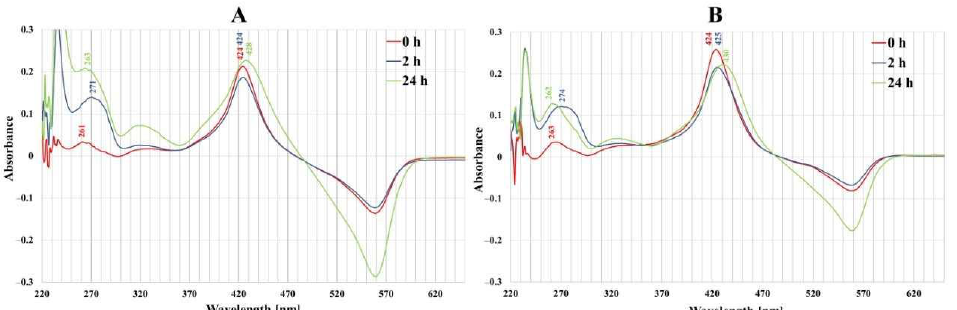
Figure 3. The UV-Vis absorption spectra of the free-base porphyrin (FB) in a post-culture media (RPMI 1640 without phenol red, 2% FCS) after 0 h, 2 h and 24 h of incubation of porphyrin with ( A ) normal colon epithelial cells (CCD 841 CoTr) and ( B ) colon cancer cells (HT29). Initial porphyrin concentration—1 µM.